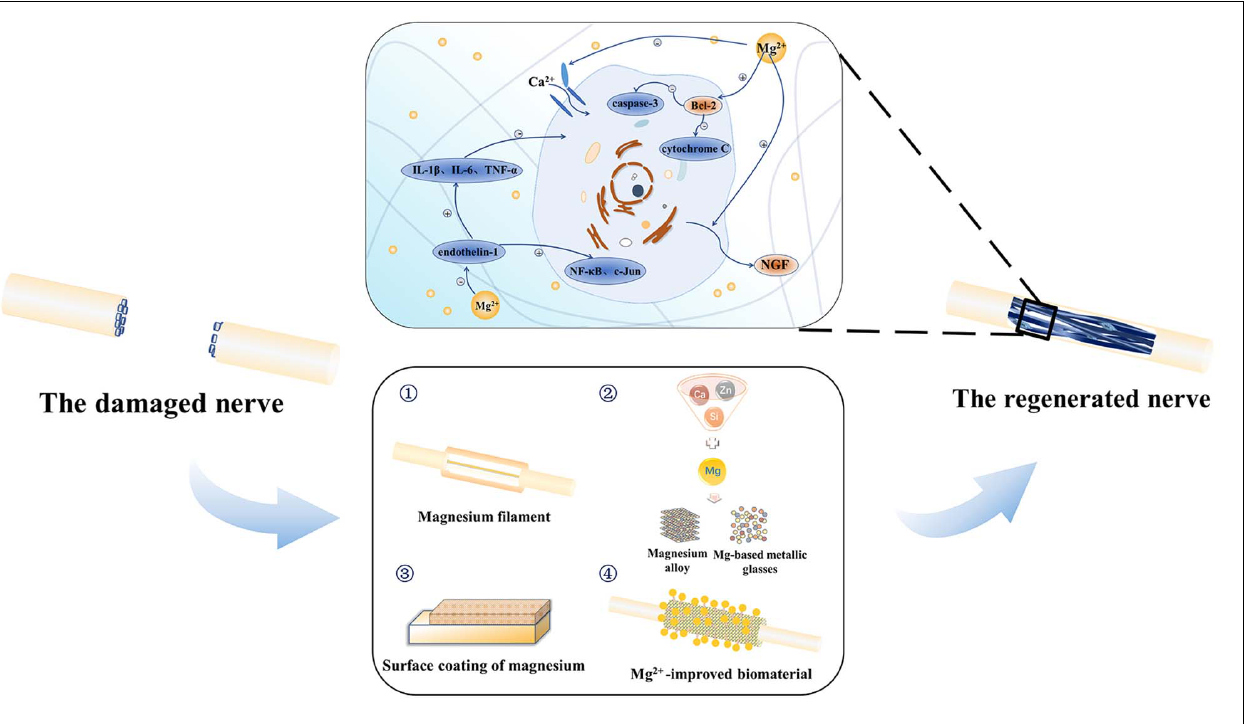
FIGURE 1 | Magnesium promotes the regeneration of the peripheral nerve.